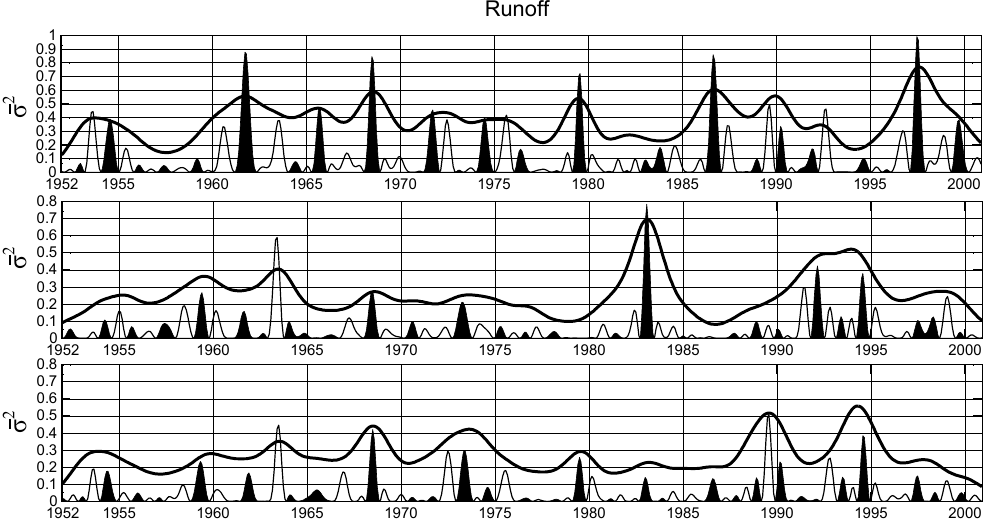
Fig. 6. The scale-averaged (0.83–5.21yr) wavelet power for runoff (thick black curve) and the bandpass filtered time series of square form (runoff squared) (thin curve) from 0.83 to 5.21yr using a wavelet filter. The upper, middle and lower panels are the first, second and third modes of runoff, respectively. The black shading indicates positive peaks in the filtered time series, while the white are negative peaks. The wavelet power and bandpass filtered time series (before squaring) are the averaged time series over the sub-basins belonging to the same mode. The averaged variances of initial monthly runoff time series σ 2 for the first, second and third modes are 263.26, 2507.64 and 1096.32mm 2 , respectively.